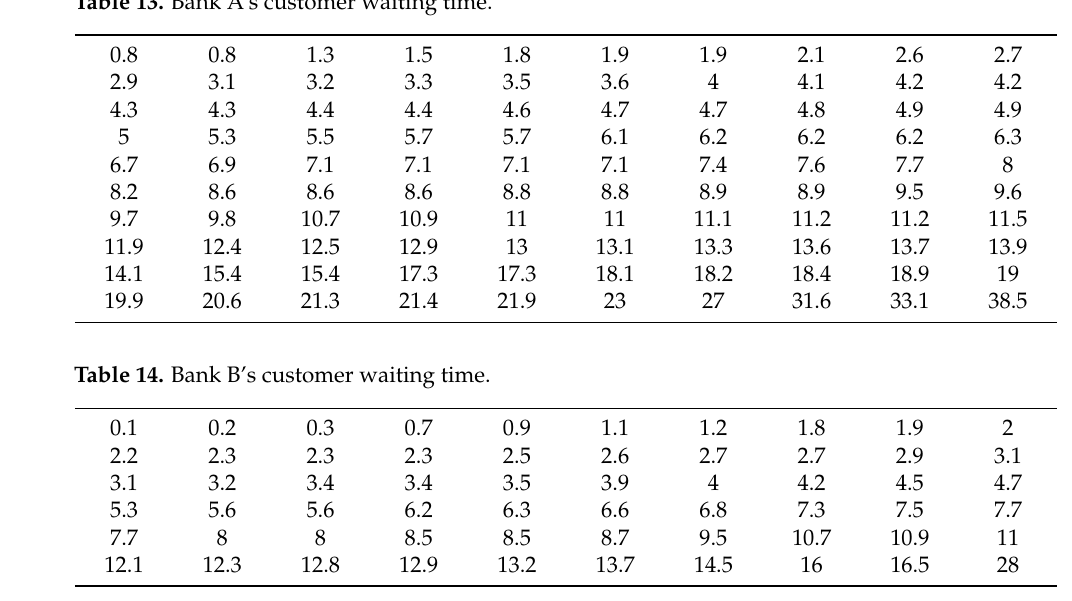
Table 13. Bank A’s customer waiting time.